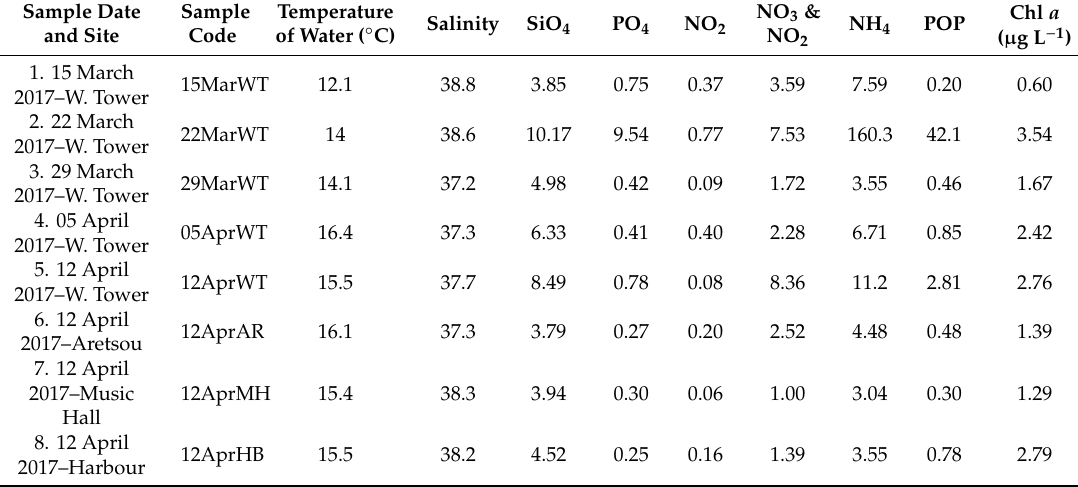
Table 2. Sample dates, sites and coding, and values of abiotic parameters (water temperature, salinity, SiO 4 , PO 4 , NO 2 , NO 3 and NO 2 , NH 4 , POP – Particulate Organic Phosphorus, Chl a ). All nutrient concentration values are given in µ mol L − 1 . The sampling sites are shown in Figure